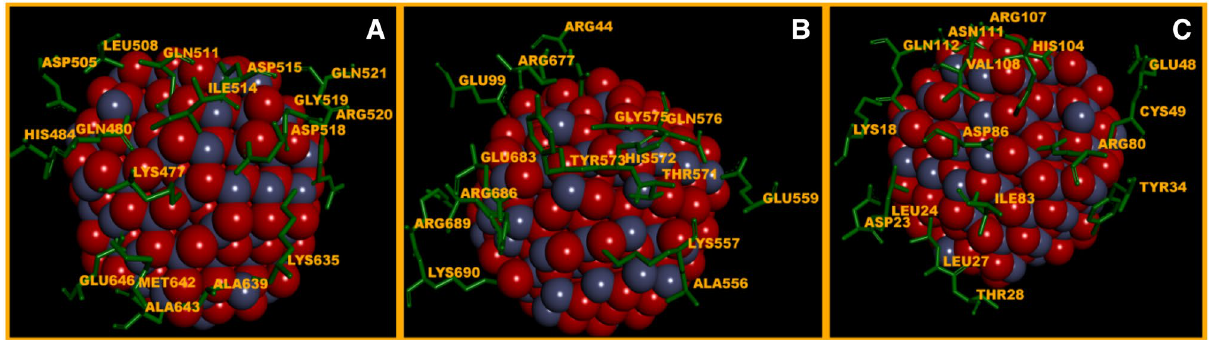
Figure 8. ( A ) The first binding site of ZnO with myosin II (Score—7982, Area—937.10 Å 2 , ACE–89.79); ( B ) the second binding site of ZnO with myosin II (Score—7524, Area—1013.40 Å 2 , ACE—159.34); ( C ) the third